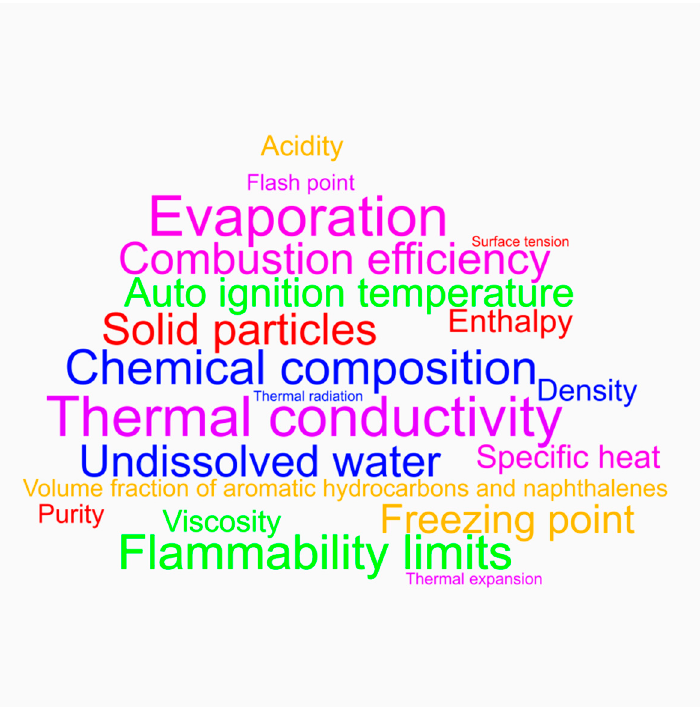
Figure 2. List of requirements for aviation fuels.